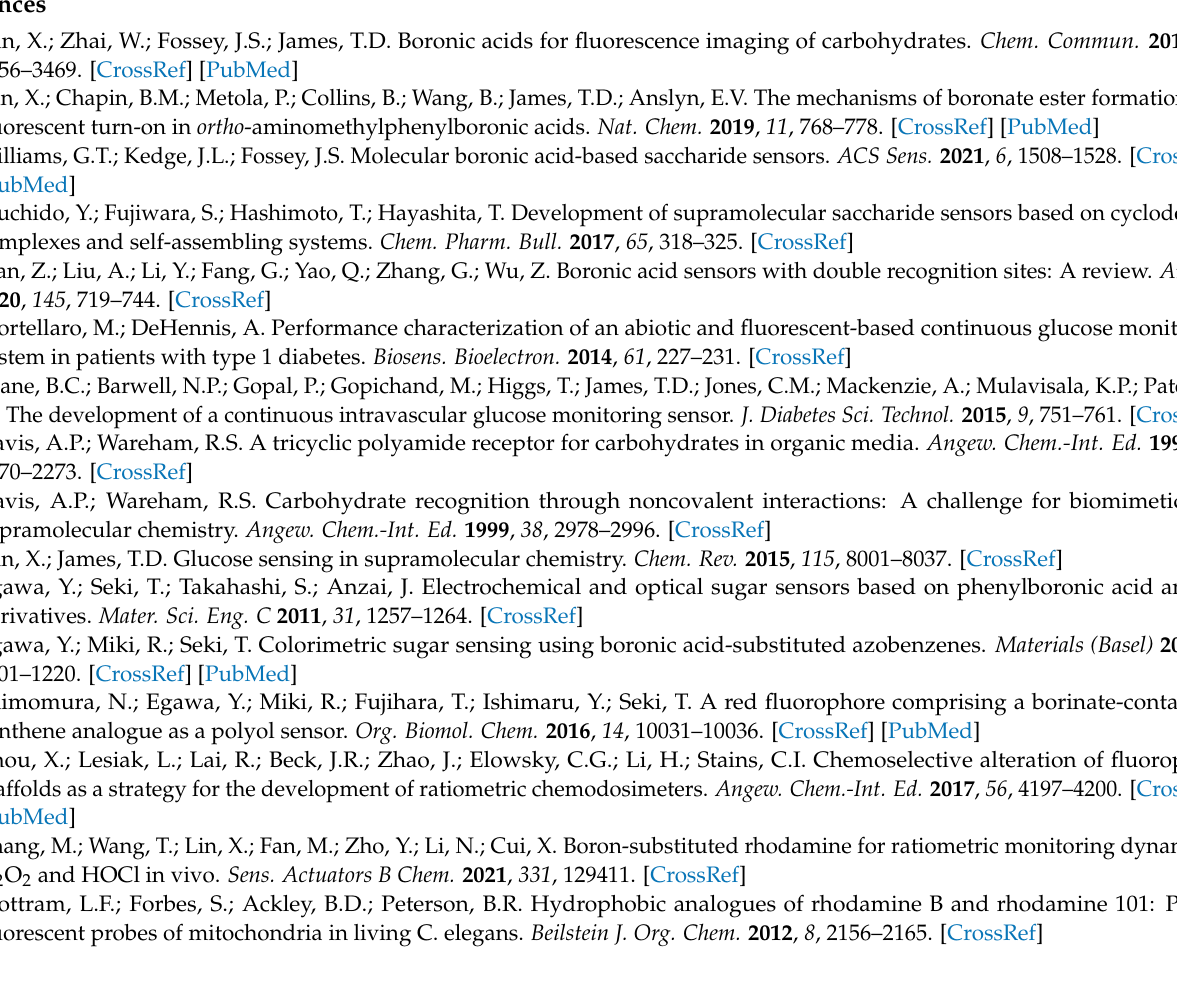
BRhoC; Figure S5: Mass spectrum of reduced BRhoC; Figure S6: The effect of pH on the absorption (a) and fluorescence (b) spectra of BRhoC (pH